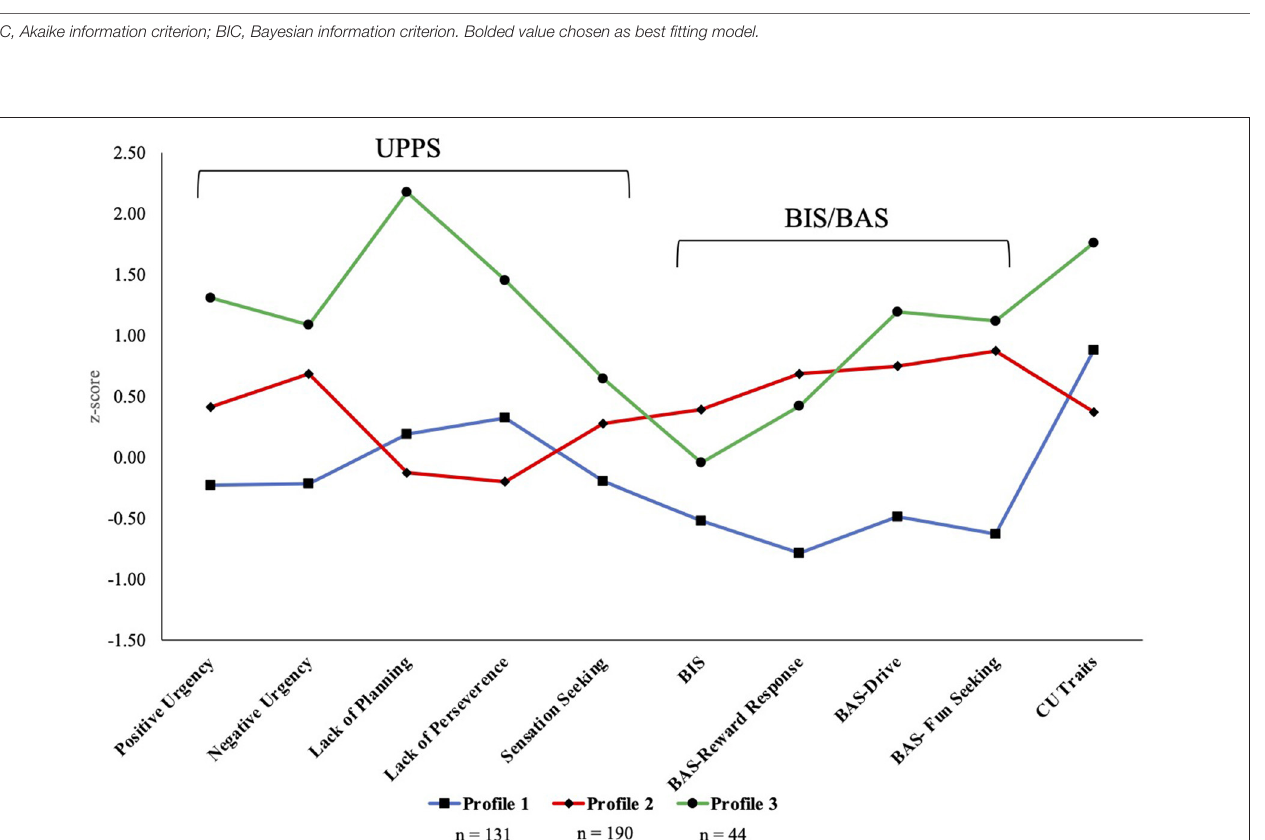
Frontiers in Psychiatry |